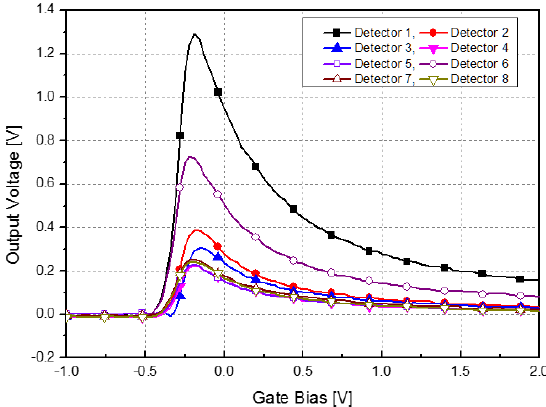
Table 1. Operating conditions of detectors in the signal conditioning block after the calibration process. Conditions